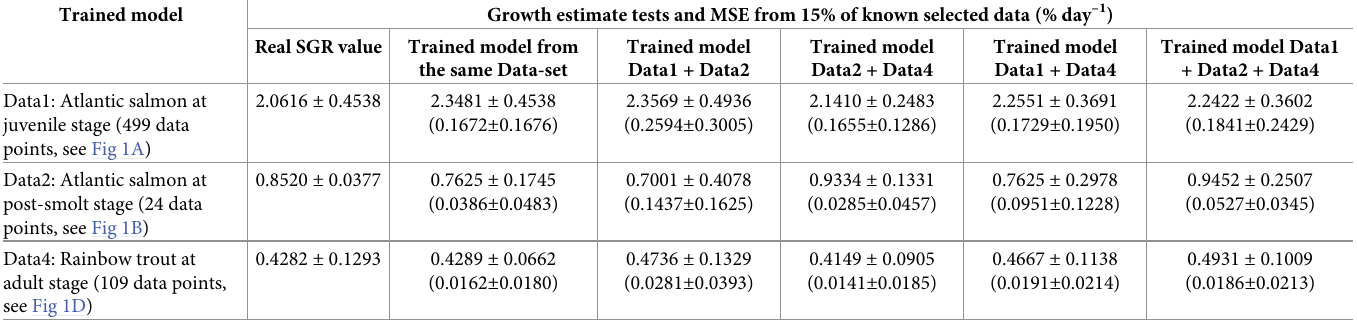
Table 3. Growth estimates of weight specific growth rate (SGR) in % per day (mean ± SD) for different datasets from different species and at different growth stages, with three inputs of normalized weight, normalized activity ratio of trypsin to chymotrypsin (T/C ratio), and normalized condition factor (CF), using differ- ent trained models from each dataset and combinations of different datasets. The values in parentheses are mean squared error (MSE) calculated from real SGR and estimated SGR values. The network time scale λ = 0.3 for the models from the same dataset, and λ = 1.0 for the other models (see Table 1). Trained